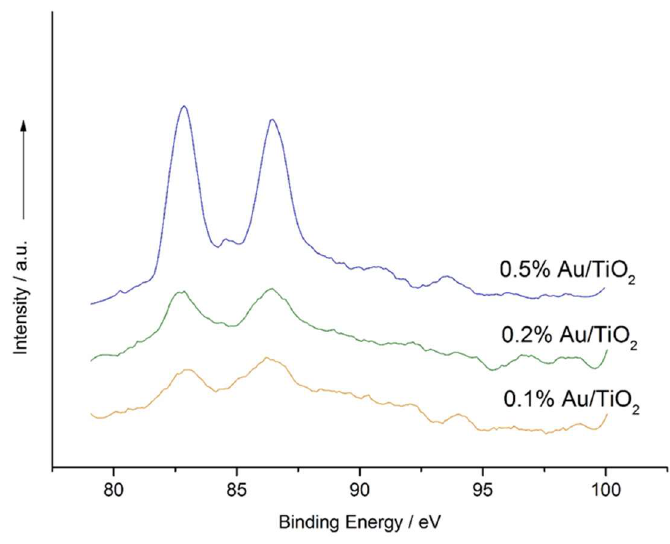
Figure 6. XPS spectra of Au 4f region for 0.1 wt. %, 0.2 wt. % and 0.5 wt. % Au/TiO 2 samples. Table 3. XPS Analysis of the surface composition of fresh samples.